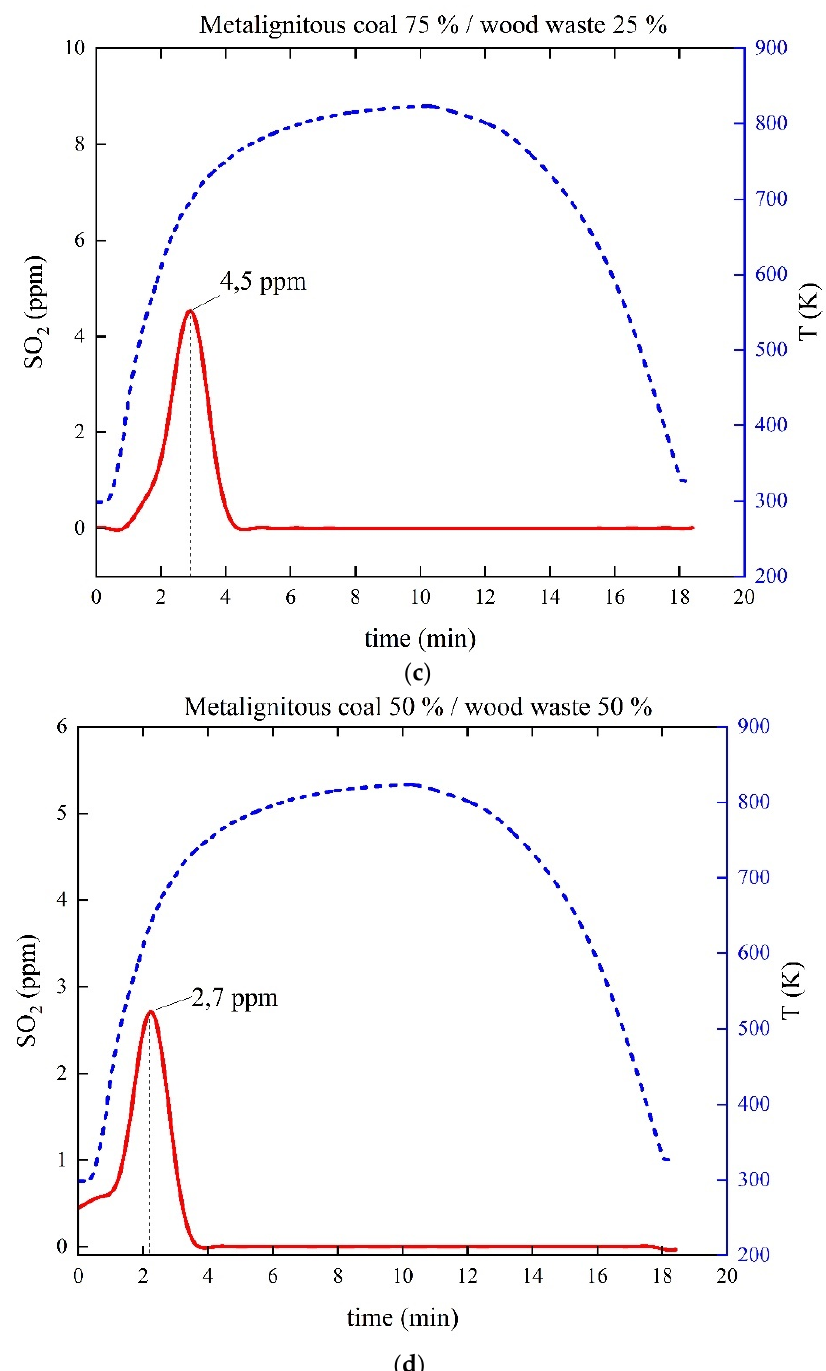
Figure 2. Changes in the concentration of sulfur oxides in the gaseous products of thermal decomposition of mixed fuels based on D-grade coal and wood with a change in the proportion of the latter in the mixture from 10% to 50%: ( a ) metalignitous coal 100%; ( b ) metalignitous coal 90%/wood waste 10%; ( c ) metalignitous coal 75%/wood waste 25%; ( d ) metalignitous coal 50%/wood waste 50%.